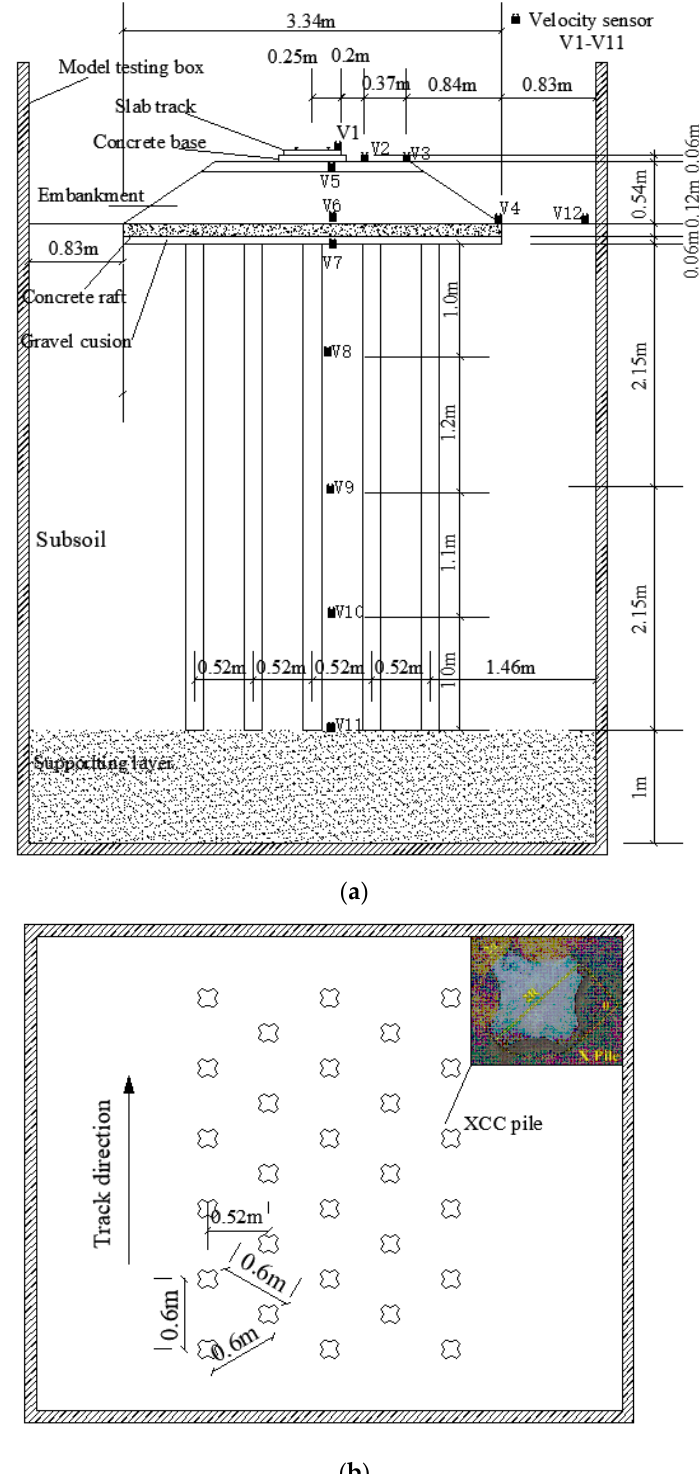
Figure 2. Geometry and instrument layout of the physical model test. ( a ) cross-sectional view, ( b ) plane view.